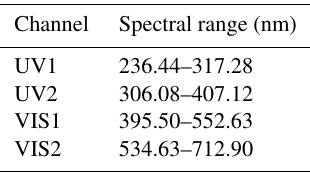
Table 2. EMI data products. Table 3. CFOV spectral